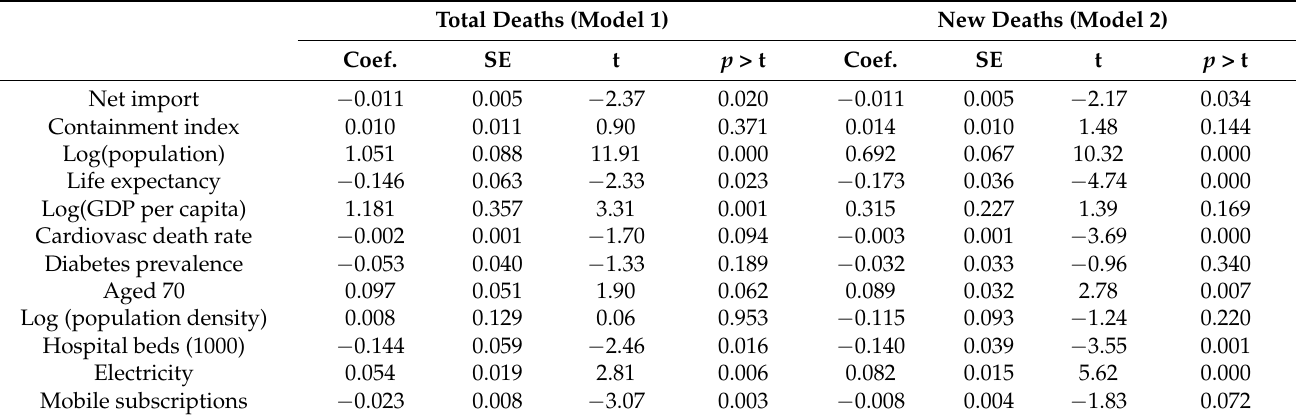
Table 3. Mustard net import and deaths caused by